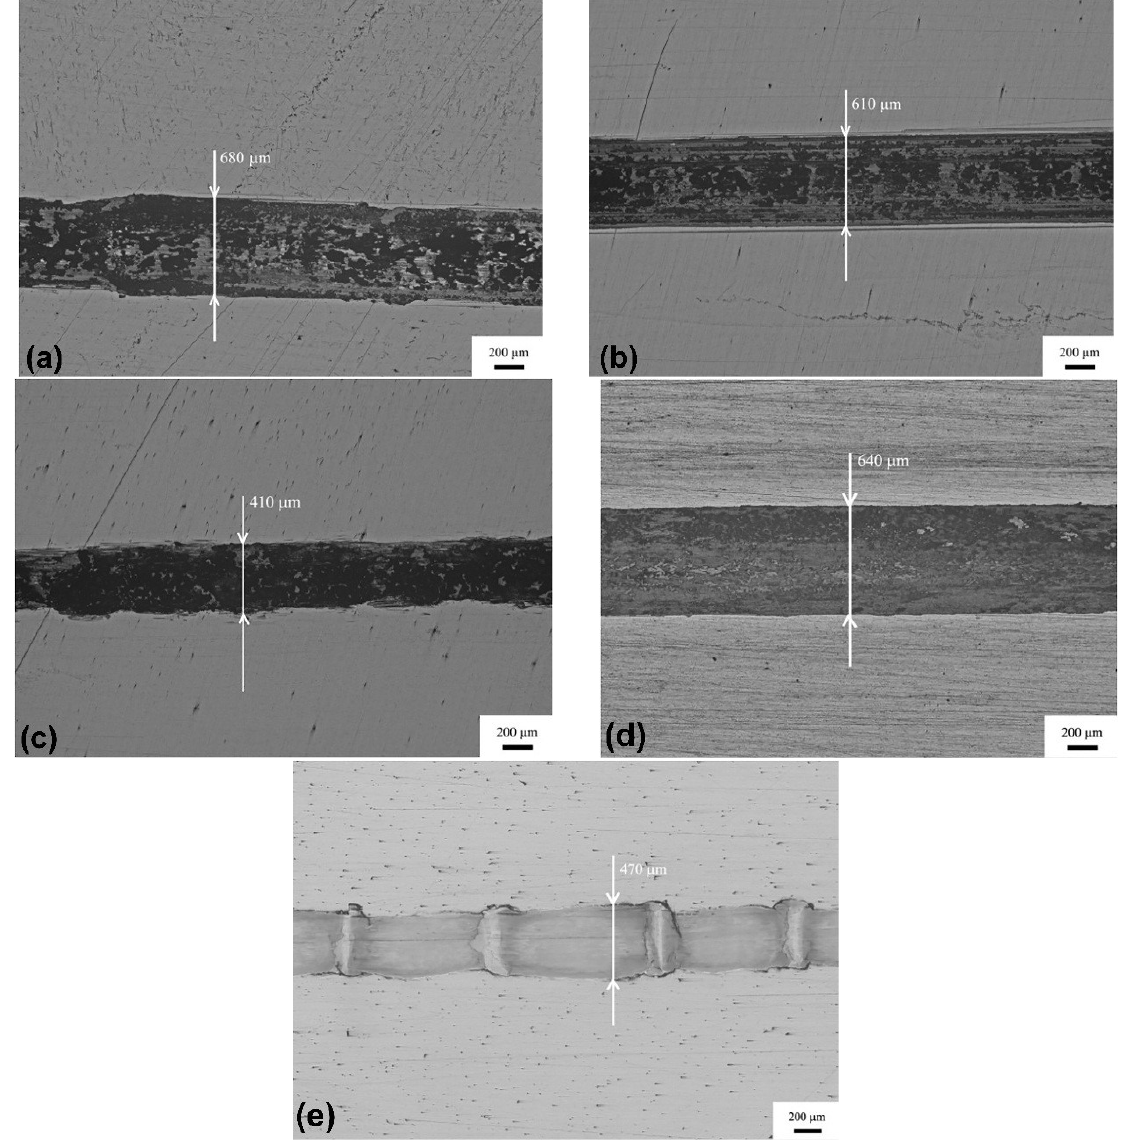
Figure 8: Track width after wear test of copper alloys at a load of 1 N: a–Cu-0,55Cr-0,2Cd-0,02Zr at 1050 ∘ C for 1 h; b–Cu-0,55Cr-0,2Cd- 0,02Zr after eight ECAP cycles; c–Cu-0,55Cr-0,2Cd-0,02Zr ECAP after eight cycles + 400 ∘ C for 1 h; d–Cu-1Cr-0,05Zr industrial processing; e–Cu-1Cd industrial